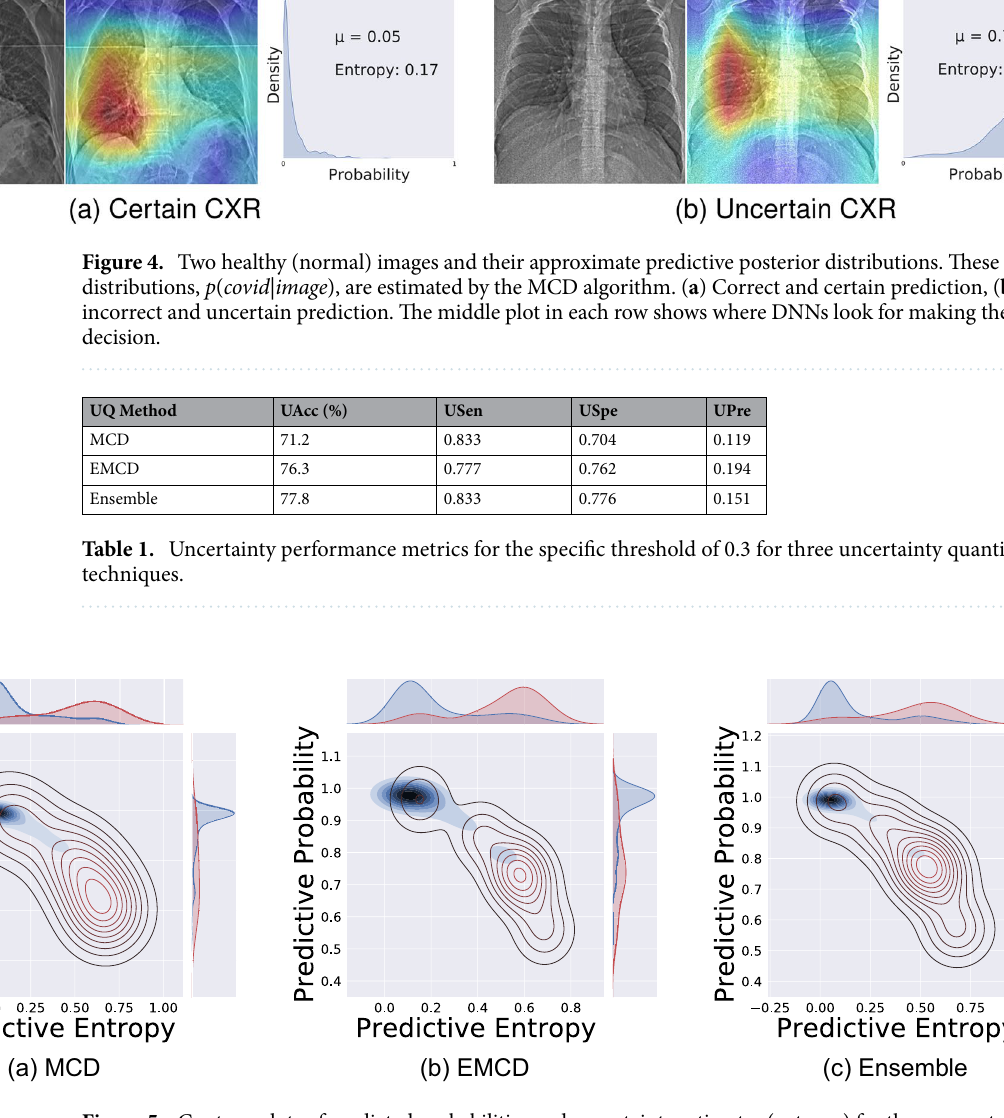
Figure 5. Contour plots of predicted probabilities and uncertainty estimates (entropy) for three uncertainty quantification methods. Distribution of estimated predictive uncertainty estimates grouped by correctly classified and misclassified are shown on the top of plots. The best separation between two groups is obtained by ensemble methods. The red lines (contours) are related to miss-classified predictions with high uncertainty and the blue ones are for correct-classified predictions with low